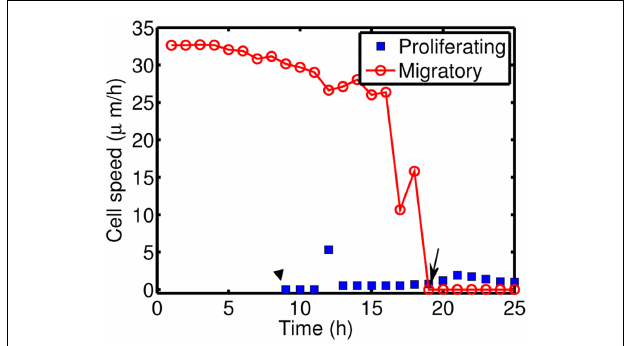
FIGURE 10 | Cell speeds of proliferative (blue square) and migratory (solid circle, red) cells in Figure